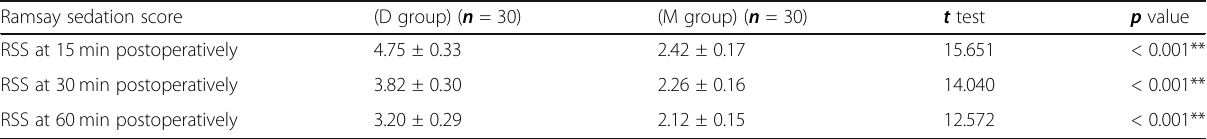
Table 8 Comparison between both groups regarding the Ramsay sedation score Ramsay sedation score (D group) ( n = 30) (M group) ( n = 30) p value RSS at 15 min postoperatively RSS at 30 min postoperatively RSS at 60 min postoperatively Using independent sample t test; ** p value < 0.001 highly